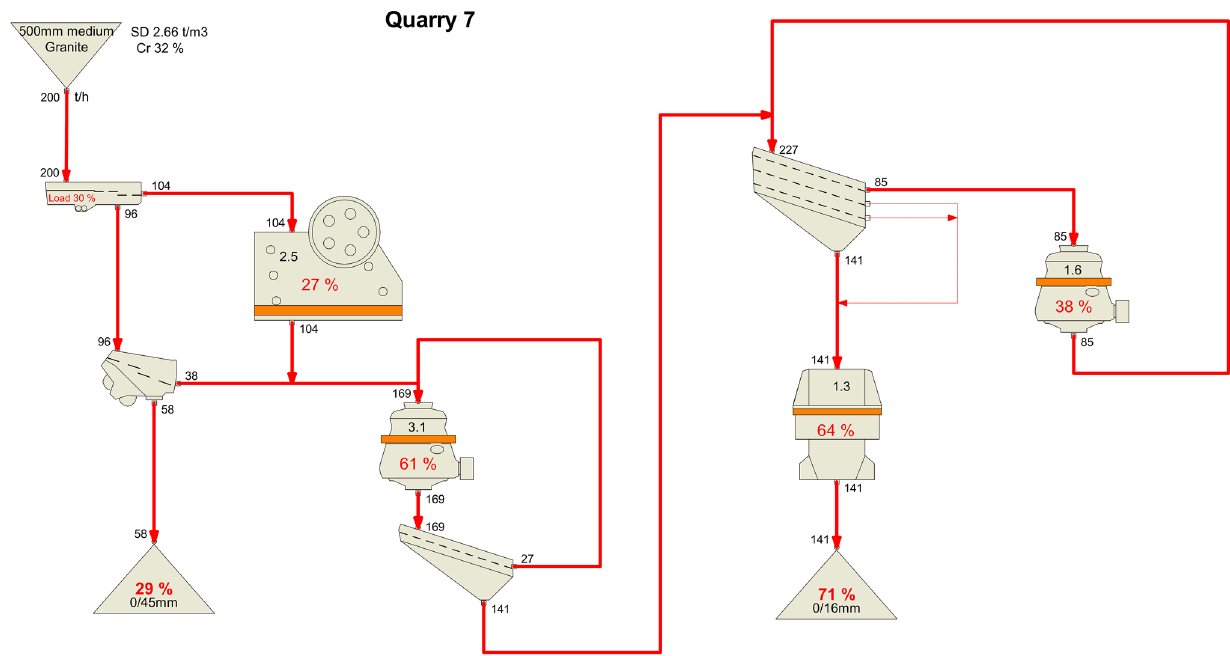
Fig. 2 The quarry 7 crushing and screening process flow. Four crushing stages, primary jaw crusher, secondary and tertiary cone crushers and quaternary horizontal shaft impactor